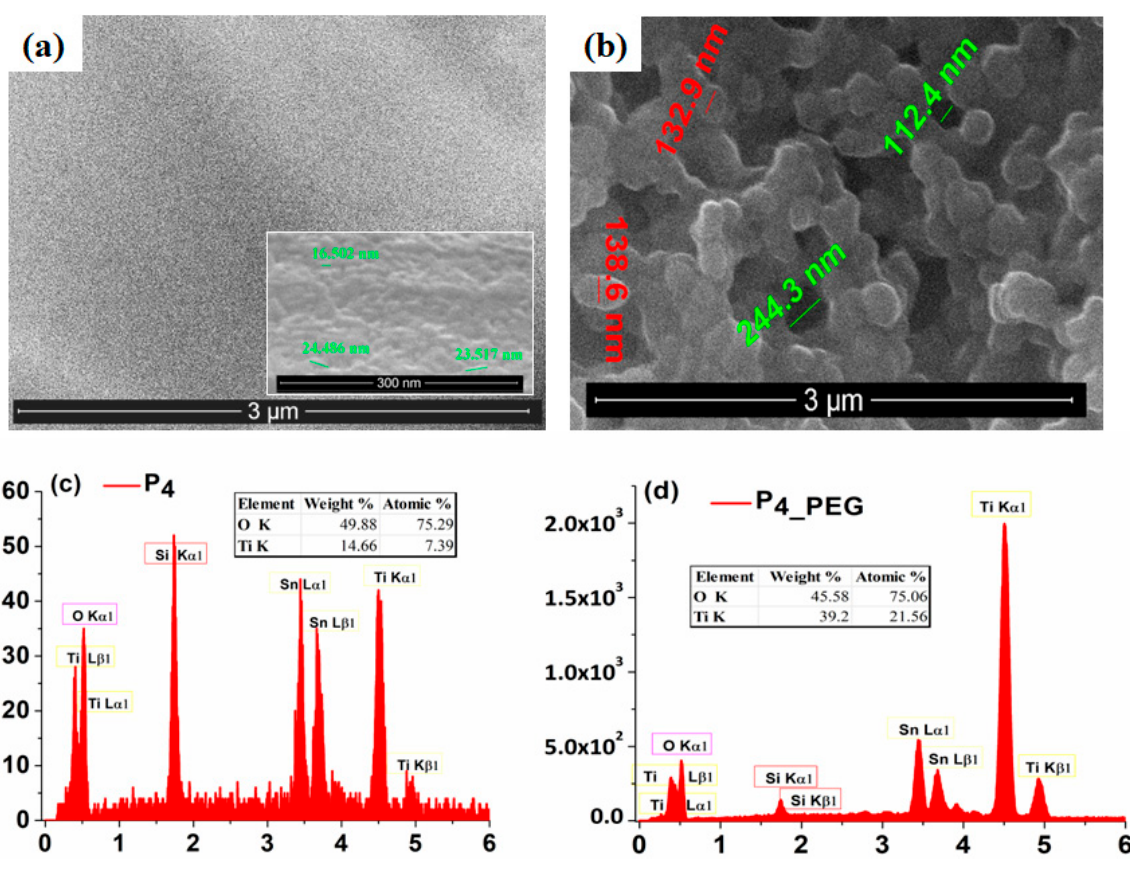
Figure 5. SEM images of ( a ) P 4 and ( b ) P 4_PEG . EDAX analysis of ( c ) P 4 and ( d ) P 4_PEG .